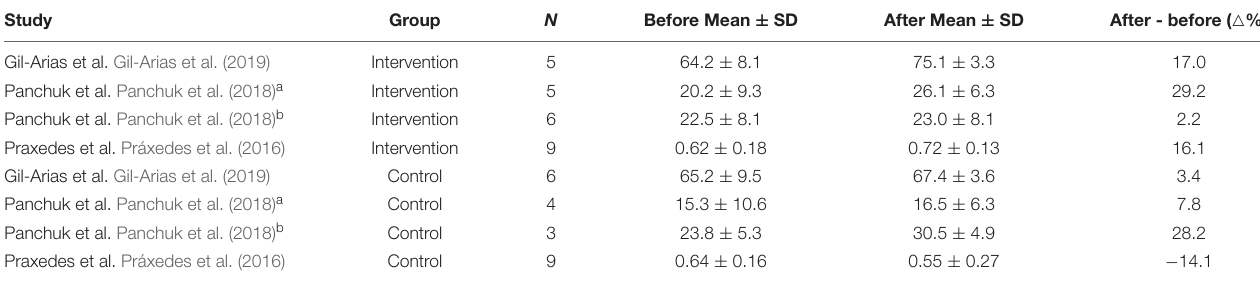
FIGURE 4 | Forest plot of within-group pre–post intervention changes in tactical behavior, in youth athletes from team sports participating in (A) decision-making training and (B) control condition. Values shown are effect sizes (Hedges’s g ) with 95% confidence intervals (CI). The size of the plotted squares reflects the statistical (relative) weight of the study. TABLE 7 | Summary of the included studies and results of technical execution before and after